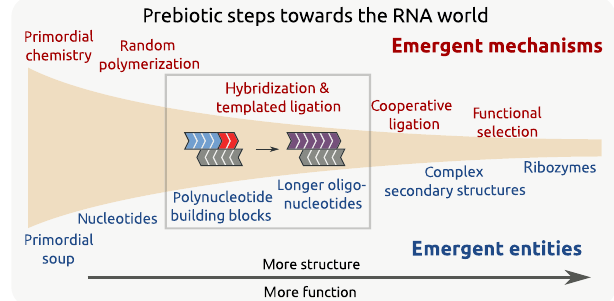
FIG. 1. Prebiotic evolution is a multistep process that creates new entities exhibiting emergent mechanisms of interaction. Our work outlines the emergence of structured oligonucleotides from the smallest building